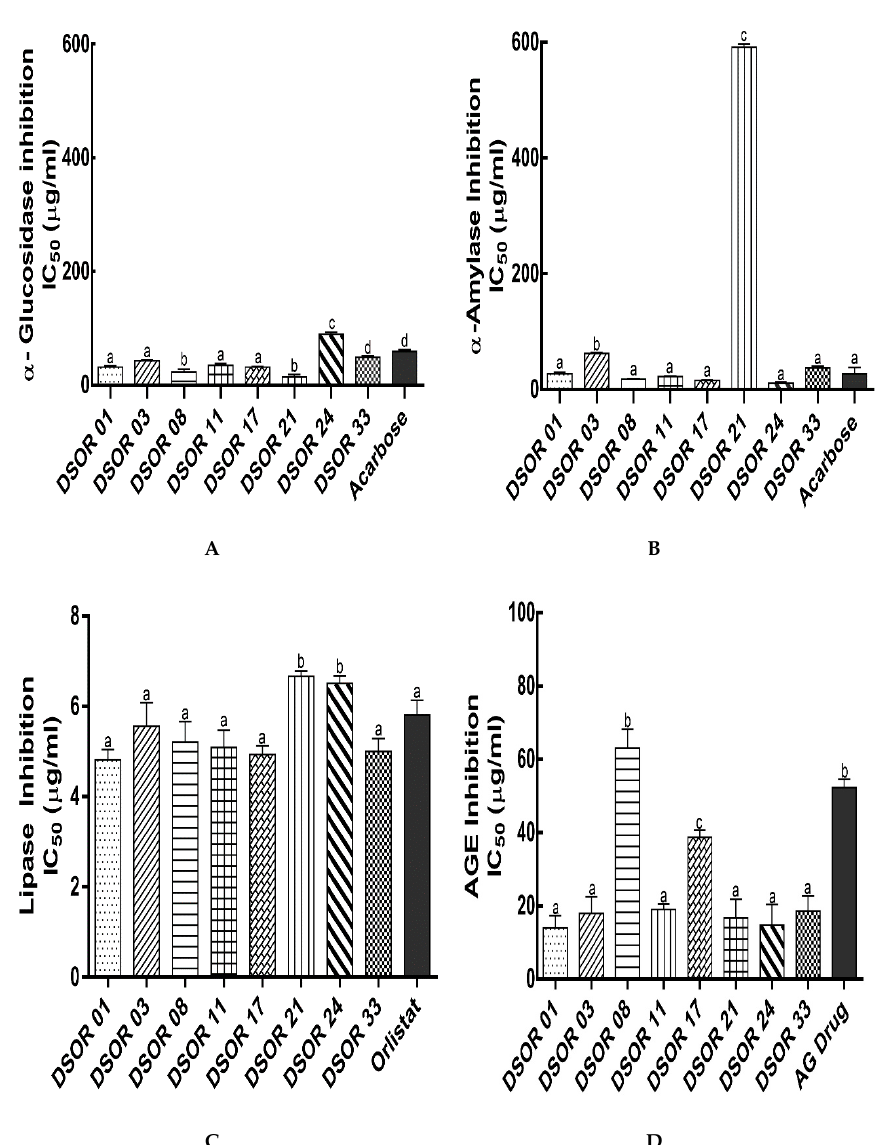
Figure 2. Digestive enzymes and advanced glycation end-products inhibitory activities from ethanol extracts of decorticated sorghum varieties. ( A ) α -glucosidase inhibitory activity IC 50 values; ( B ) α -amylase inhibitory activity IC 50 values; ( C ) lipase inhibitory activity IC 50 values and ( D ) AGEs inhibitory activity IC 50 values. AG, aminoguanidine. Different lowercase letters denote significant difference ( p < 0.05).